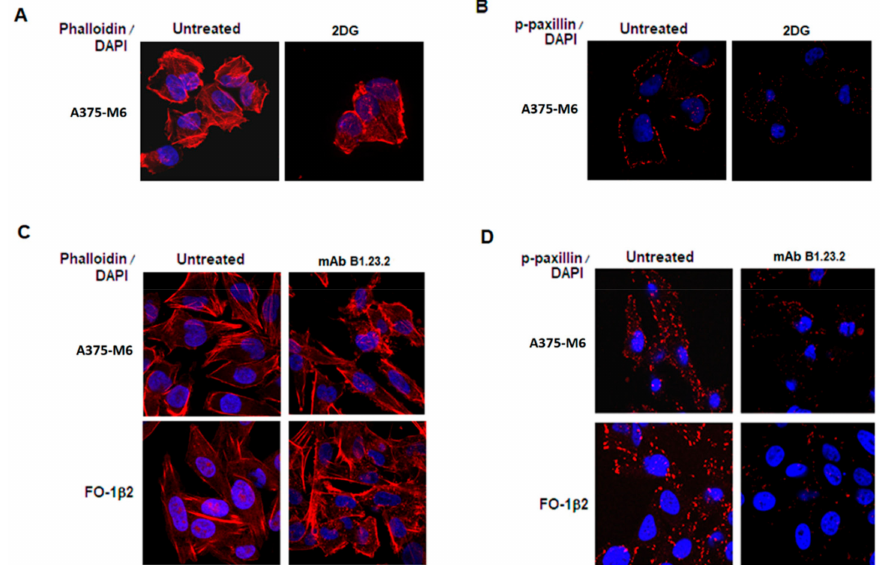
Figure 6. Staining of F-actin with rhodamine–Phalloidin ( A ) and intracellular localization of phospho-paxillin ( B ) in A375-M6 treated with 20 mM 2DG for 24 h at 37 ◦ C. Staining of F-actin with rhodamine–Phalloidin ( C ) and intracellular localization of phospho-Paxillin ( D ) in A375-M6 and FO-1 cells treated with the HLA-B,C-specific mAb B1.23.2 (10 µ g / mL) for 24 h at 37 ◦ C. Scale bar = 10 µ